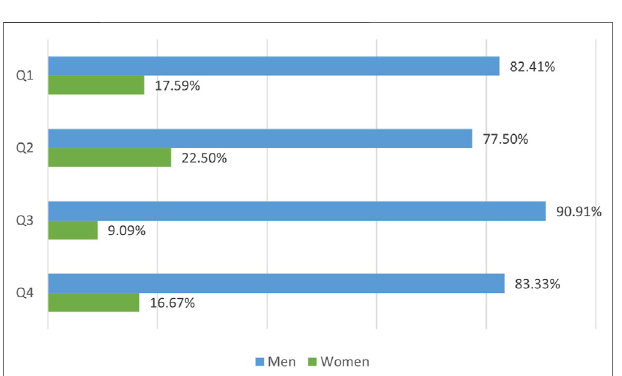
FIGURE 4 | Average gender composition of the editorial boards by quartile ranking of six journals classi fi ed in 2020 within the category of “ Geology ” in Emerging Sources Citation Index ™ , and included in Science Citation Index Expanded ™ in other categories (Agriculture, Multidisciplinary and Geosciences, Multidisciplinary).